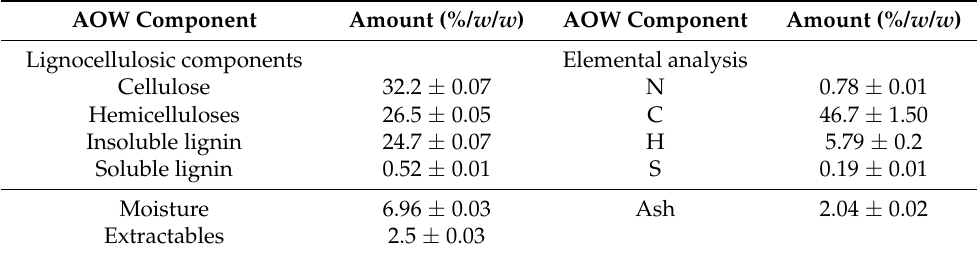
Table 1. Chemical composition (% w / w ) of the apple orchard waste